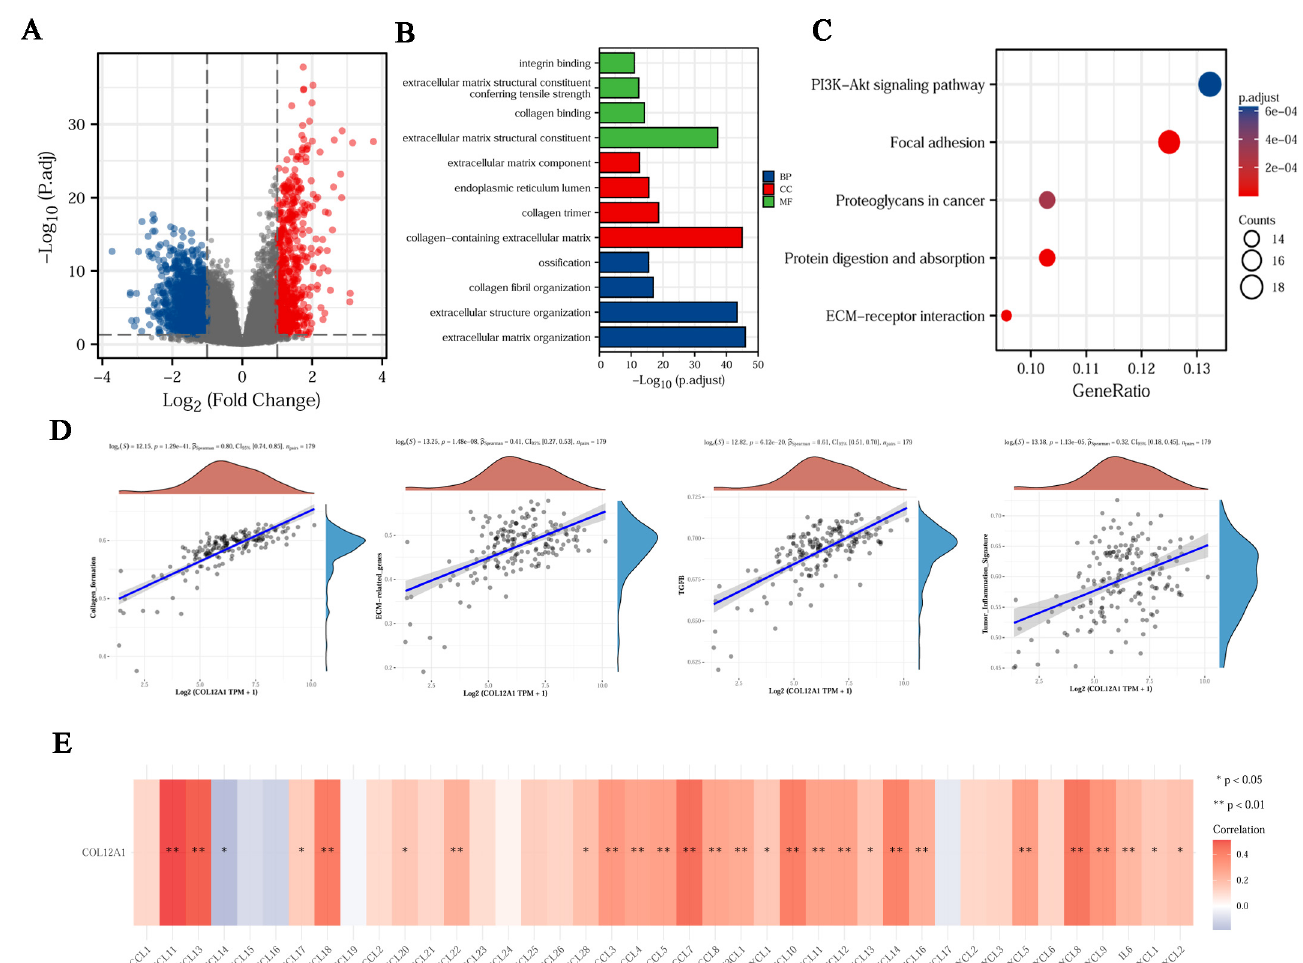
Figure 8. Enrichment function for COL12A1. ( A ) Volcano plot of DEGs between high and low COL12A1 expressions. ( B ) GO analysis of the DEGs based on the COL12A1 expression in pancreatic cancer. ( C ) KEGG analysis of the DEGs based on the COL12A1 expression in pancreatic cancer. ( D ) COL12A1 and associated pathway in high and low COL12A1 expressions. ( E ) Correlation of COL12A1 expression and chemokines in